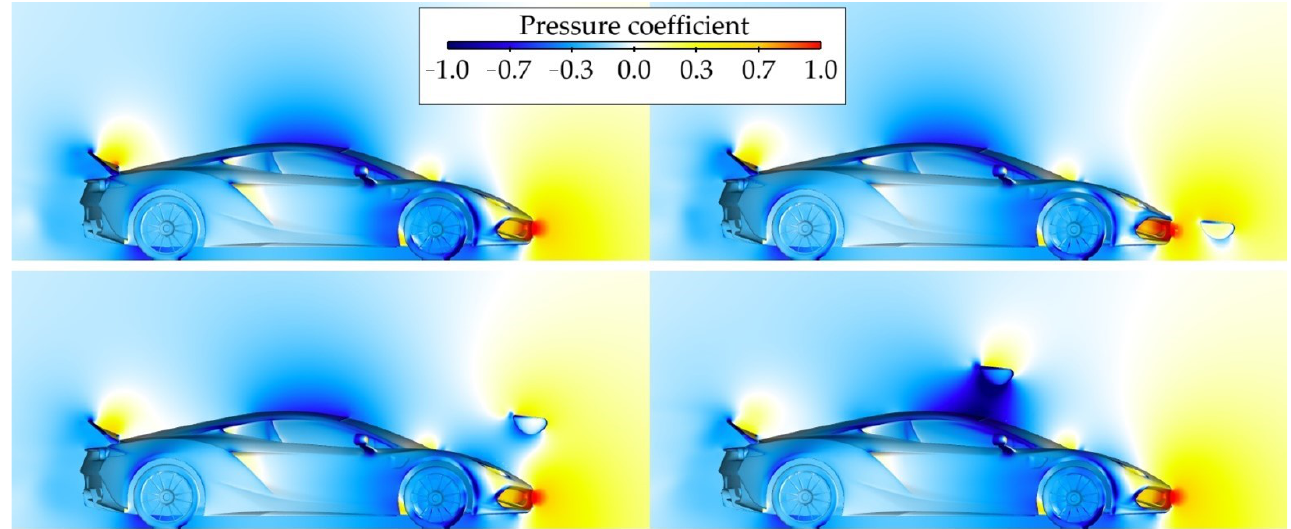
Figure 31. Velocity streamlines around a vehicle without a front wing and for a vehicle with three different wing positions: ( a ) front view; ( b ) rear view. Visualizations are mirrored along the symmetry plane.